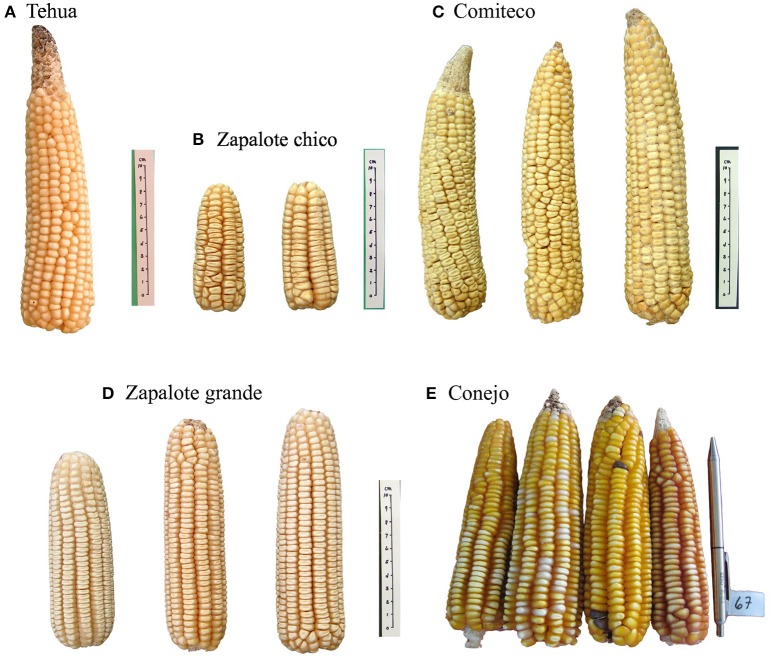
Representative images of each of the landraces used in this study, note the difference in cob size among them. Images credit: Instituto Nacional de Investigaciones Forestales Agrcolas y Pecuarias (INIFAP) and Global Maize Project (CONABIO, 2011).